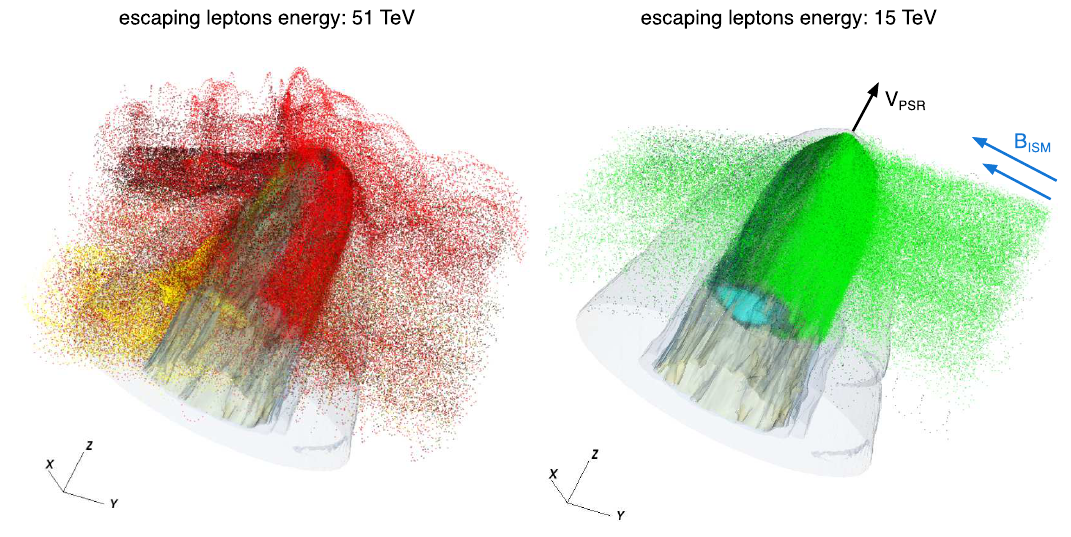
Figure 8. Maps of bow shock nebulae from 3D MHD simulations with density contours (in gray color) and the flux of escaping leptons (of two different energies). Dots of different colors indicate particles injected at different locations in the pulsar wind: the majority of escaping particles are injected in the polar region of the wind (red and green), while very few of them come from the equatorial region. In both plots, the PSR direction of motion is aligned with the Z direction, while the magnetic field, with strength B ISM = 0.01 ρ ISM V 2 (with ρ ISM the ISM mass density) lies in the orthogonal plane. Plots have PSR been elaborated based on the simulations presented in [138]. The figure on the left is reprinted from Olmi & Bucciantini 2019 © 2019 Olmi &